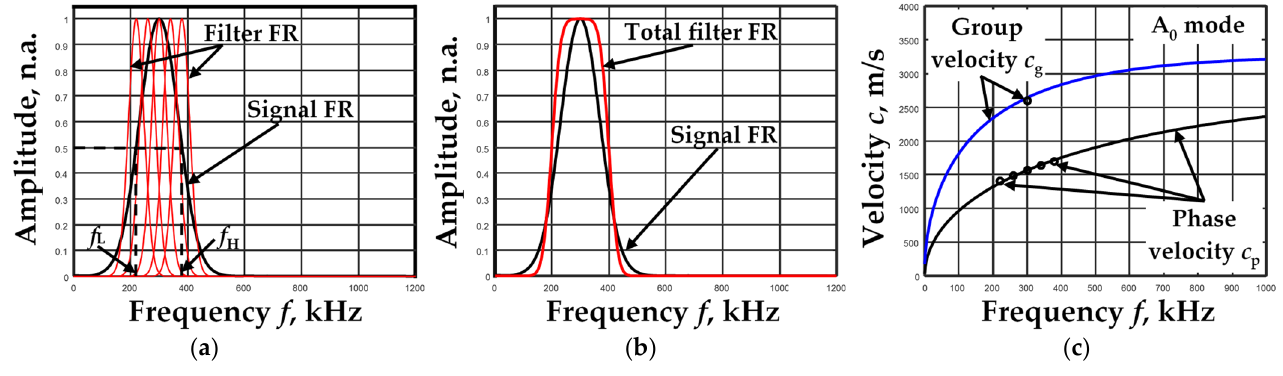
Figure 7. The frequency responses (FR) of the f ex = 300 kHz signal and n = 5 filters when using filter bandwidth R = 2.5 ( a ), total frequency response of the filters ( b ), values of phase and group velocities calculated for the proposed algorithm (dots) and dispersion curves calculated using the SAFE method (lines) ( c ).